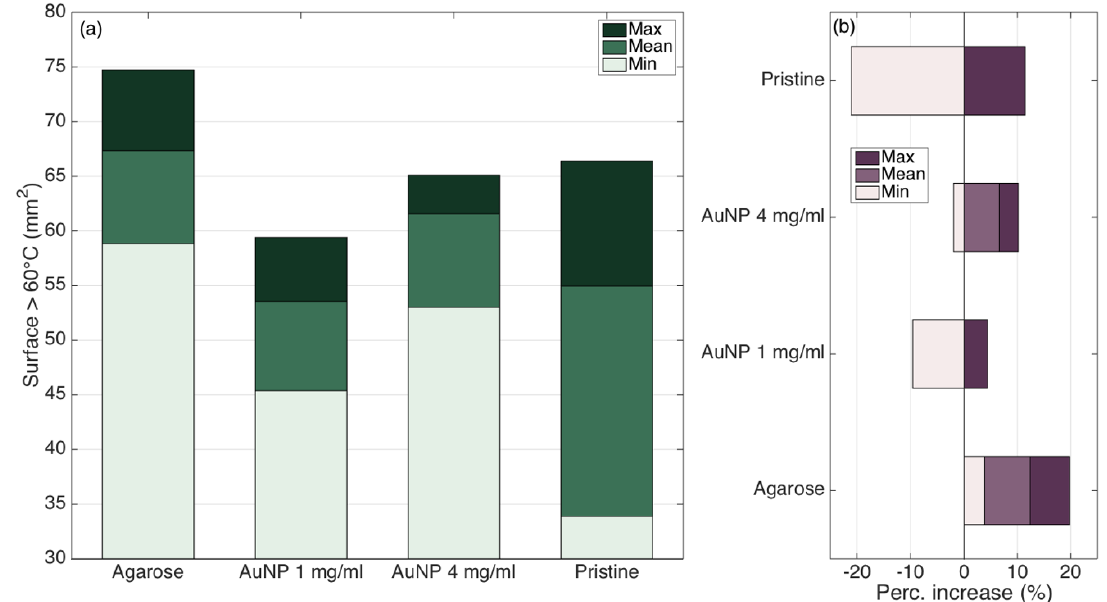
Figure 13. Quantification of the thermal damage region (temperature >60 °C) for each experimental condition. ( a ) Evaluation of the surface exposed to temperature exceeding 60 °C at the maximum ablation temperature; bar charts show the maximum (dark), minimum (bright), and mean (interme- diate) values of the areas, over four experiments for each RFA condition. ( b ) Percentual increase or decrease for the ablated surface, with respect to the reference condition (pristine RFA, mean sur- face).